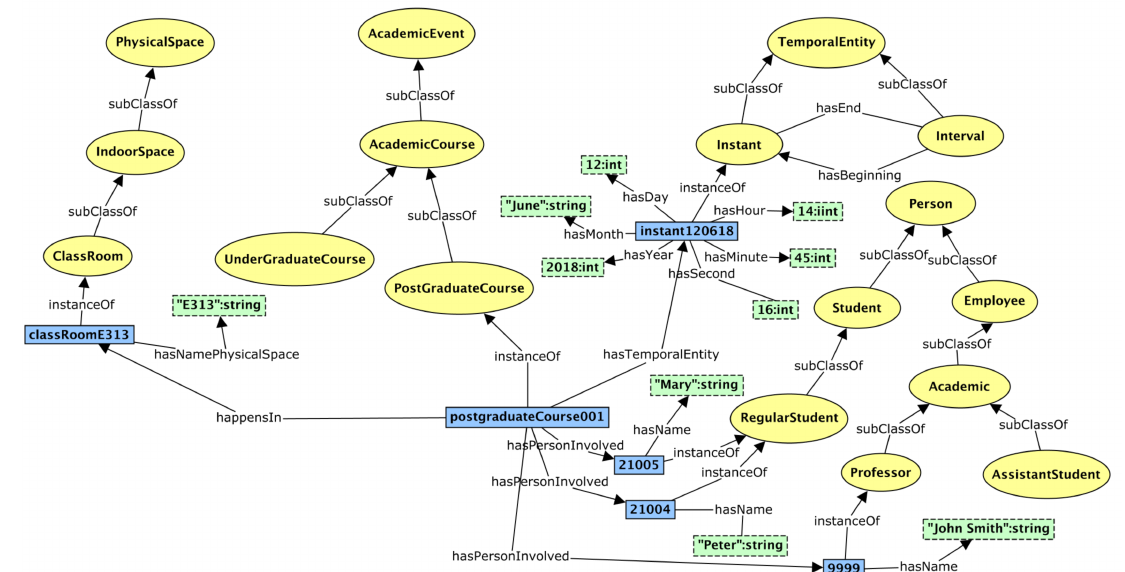
Figure 8. Ontological model instantiated with an academic course event (scenario 2).